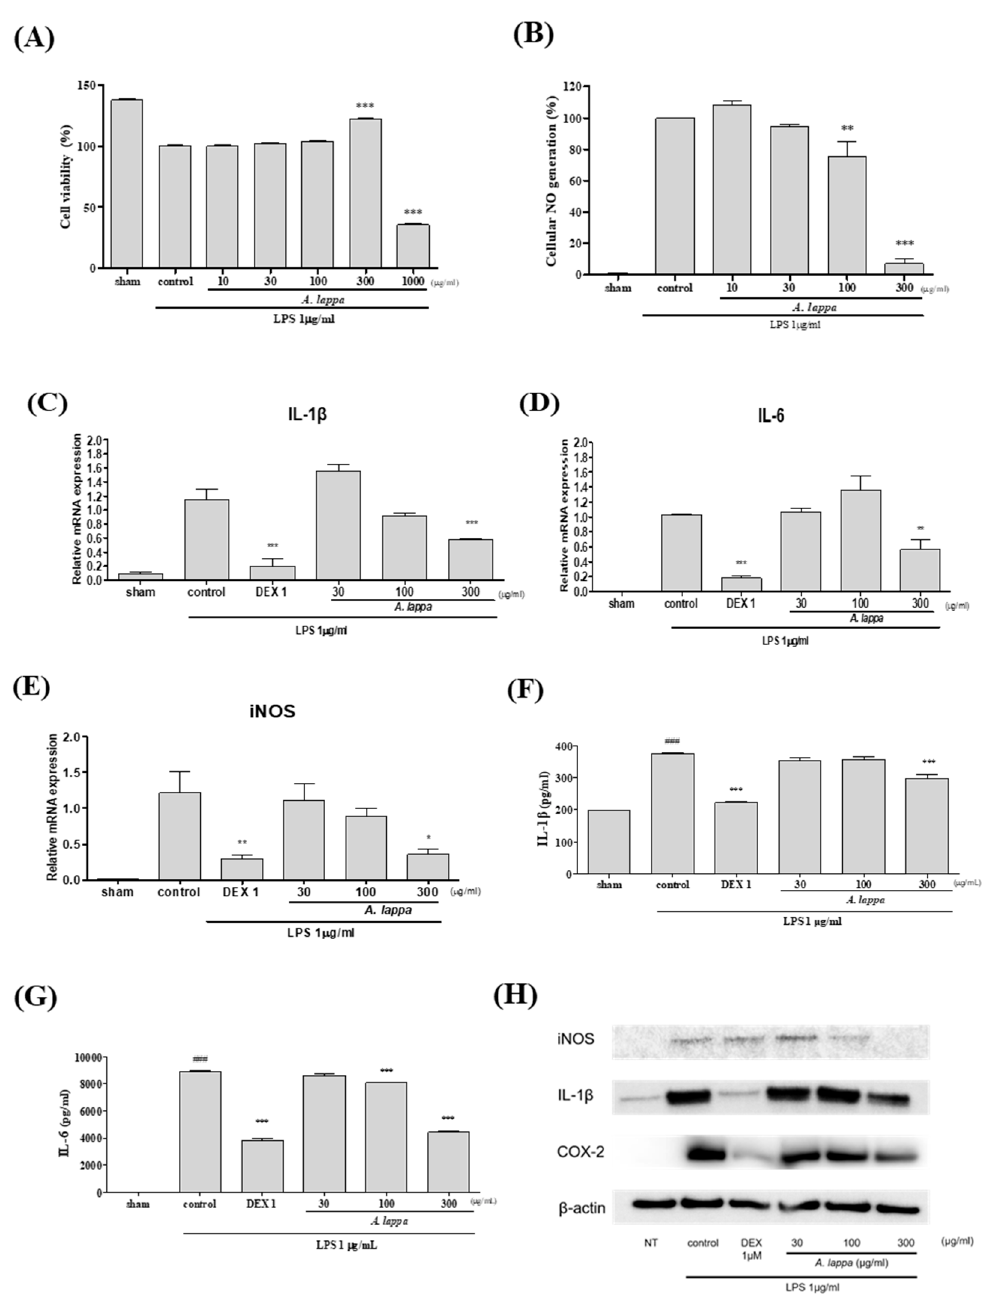
Figure 6. Effects of Aucklandia lappa treatment on ( A ) Cell viability ( B ) NO generation mRNA levels of ( C ) IL-1 β , ( D ) IL-6, and ( E ) iNOS. Protein expression of ( F ) IL-1 β , ( G ) IL-6, and ( H ) Western blot assay was performed for observing the protein expression. Protein expression of the cytokines was analyzed using multiplex analysis kit and through Western blotting. ### p < 0.001 vs. sham, * p < 0.05, ** p < 0.01, *** p < 0.001 vs. control.